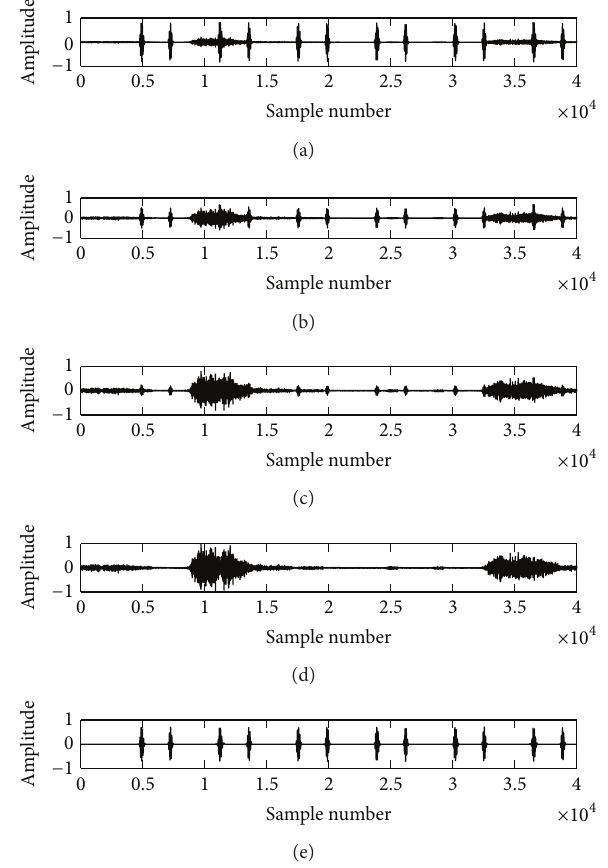
Figure3:GraphicalresultsoftheEMDbasedHSremovaltechnique (proposed by us). (a) It shows the waveform of a mixed LS signal (20% LS + 80% HS). (b) It shows the waveform of a mixed LS signal (50% LS + 50% HS). (c) It shows the waveform of a mixed LS signal (80% LS + 20% HS), (d) Reconstructed LS signal, (e) Residual HS